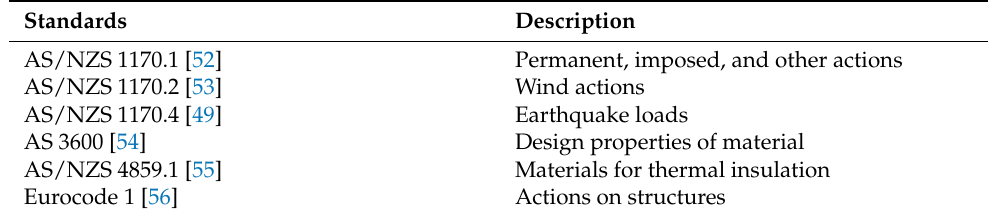
Table 3. Standards used in the